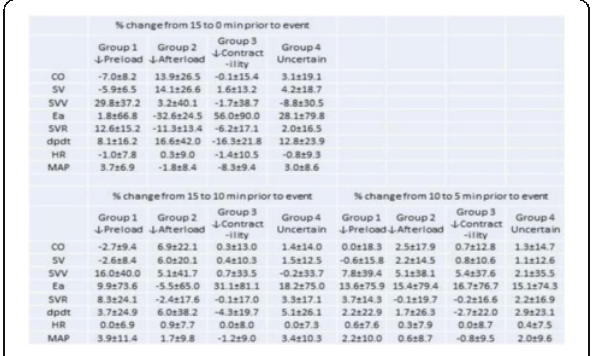
Fig. 75 (abstract A176). % change values (mean ± standard deviation) from 15 to 0 minutes prior to event (used in classification of groups); 15 to 10 min; and 10 to 5